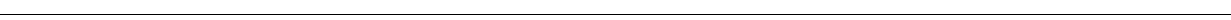
Fig. 1 Characterisation of oligomers and their effect on mitochondria. a Representative SAVE images of early oligomers (4 h), late oligomers (8 h), and fi brils (24 h). Zoom and representative two-dimensional Gaussian distribution fi ts are shown in the insets. The scale bar is 5 µ m and 1 µ m in the zoom, and the colour bar shows the Gaussian amplitude (×10 4 photons). b Quanti fi cation of aggregation. Each detected species was fi tted to a two-dimensional Gaussian distribution, and histograms of the widths (FWHM) along the longest axis, and the total integrated intensities are shown for each time-point. c Representative traces from single experiments, of NADH auto fl uorescence in WT neurons exposed to either monomers ( n = 15 cells), oligomers ( n = 32 cells), or oligomers ± CsA ( n = 9 cells and n = 6 cells, respectively). d Representative Rh123 traces of cells challenged with oligomers. e Quanti fi cation of mitochondrial depolarisation upon either monomeric or oligomeric application. N = 3 experiments; Oligomers: n ≥ 60 neurons/astrocytes; Monomers: n ≥ 50 neurons/astrocytes. f Representative Rh123 traces of cells challenged with oligomers. g Representative Rh123 traces of cells challenged with oligomers ± CsA. h Representative traces of Rh123 and fura-2 in WT neurons exposed to glutamate in the presence of monomers or oligomers. i Representative images of WT rat neurons labelled with fl uo-4 (cytosolic calcium) and TMRM ( ΔΨ m) before (0 min) and after (4 min) high laser exposure which represents PTP opening. A representative trace of TMRM and Fluo-4 fl uorescence where the drop in TMRM fl uorescence precedes increase in Fluo-4 fl uorescence. Quanti fi cation of the time until PTP opening in WT cells pre-exposed to oligomeric α -synuclein. N = 3 experiments; n = 43 cells for control and n = 20 cells for oligomers. Two-tailed Student ’ s t -test for e and i . Scatter points represent individual cells for e and i . Scale bar = 10 μ m. Data represented as mean ± SEM. * p < 0.05; ** p < 0.01; *** p <